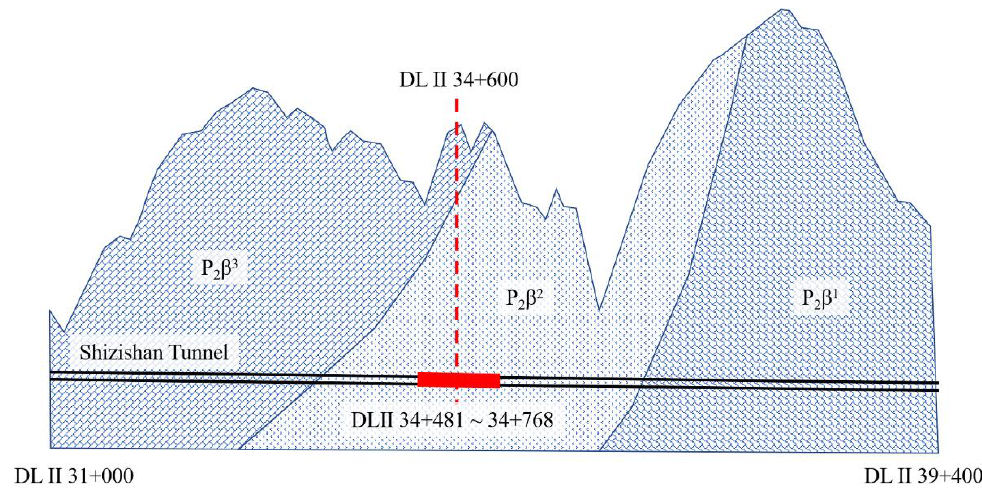
Figure 2. The profile of physical and mechanical indicators of the rock mass in section DLII34+481~34+768. Table 1. Mechanical properties of the rock mass of the Shizishan